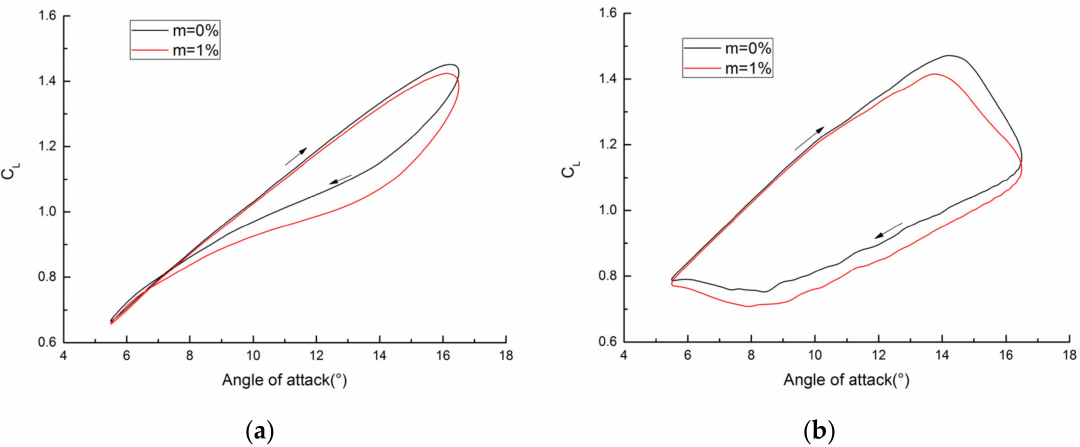
Figure 13. Hysteresis loops of two airfoils for Case 5: ( a ) NACA0012 airfoil; ( b ) S809 airfoil.